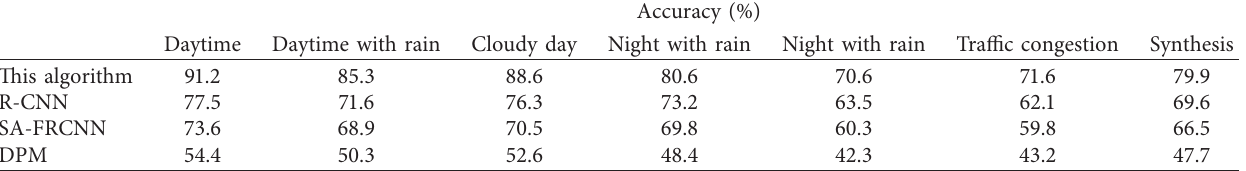
Table 2: Comparison of accuracy between this algorithm and other